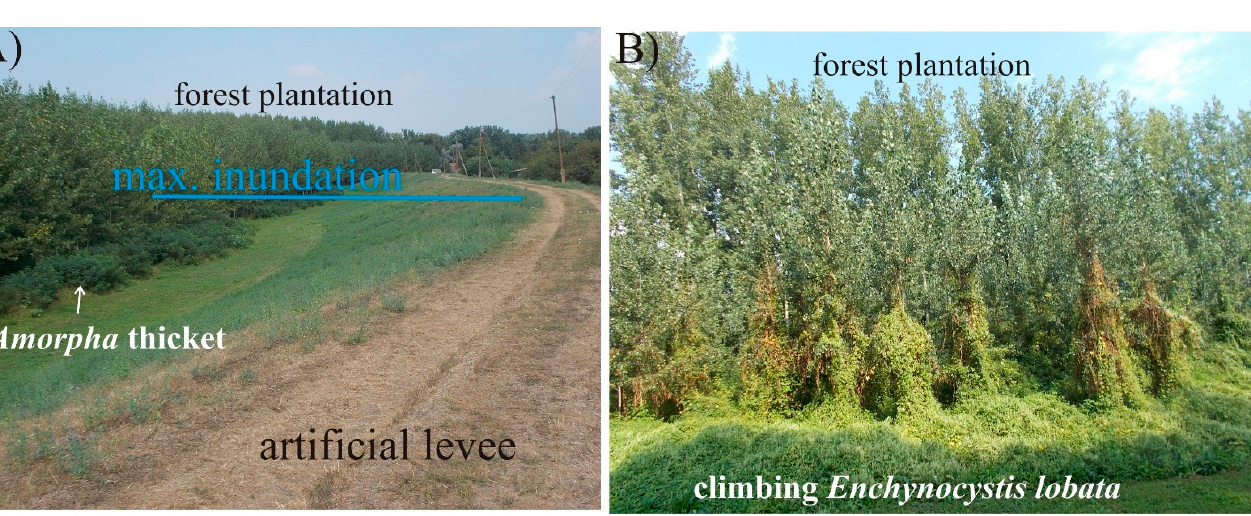
Figure 2. On the confined floodplain, the planted forests are invaded by ( A ) false indigo ( Amorpha fruticosa ) bushes and ( B ) climbing wild cucumber ( Enchynocystis lobata ).